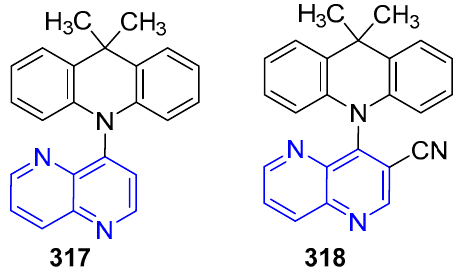
Figure 40. Thermally activated delayed fluorescence (TADF) emitters in OLED.